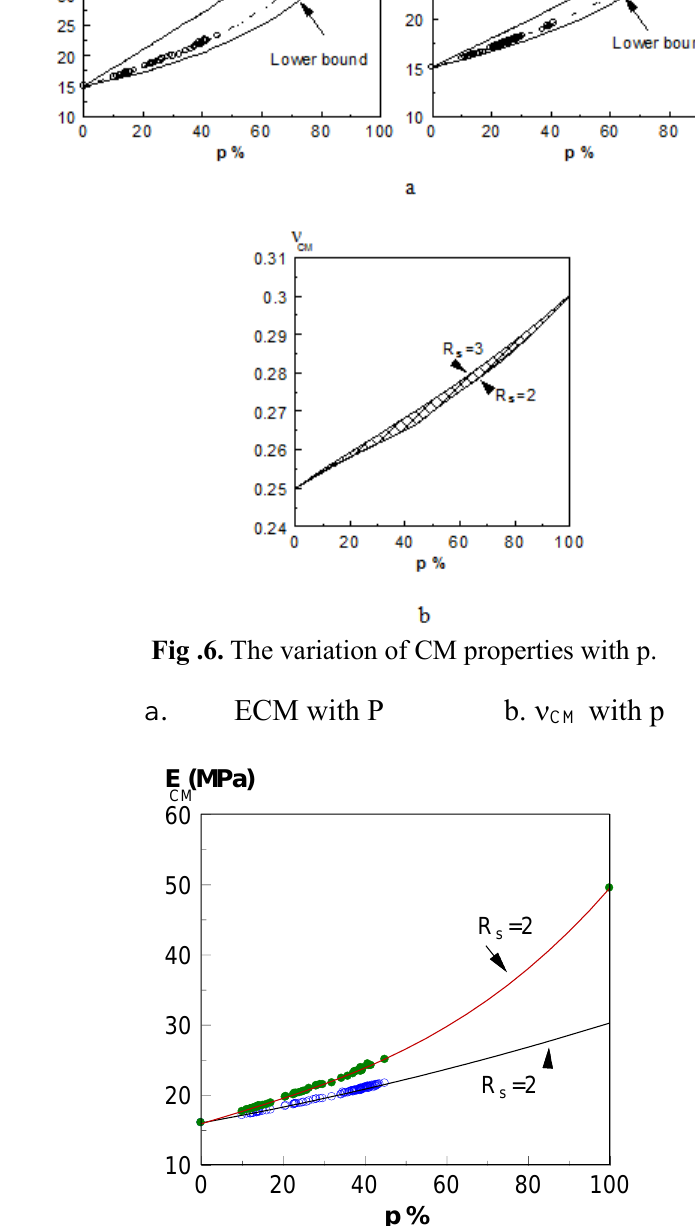
Figure 6: The variation of CM properties with p (continued) (b) nu CM with p